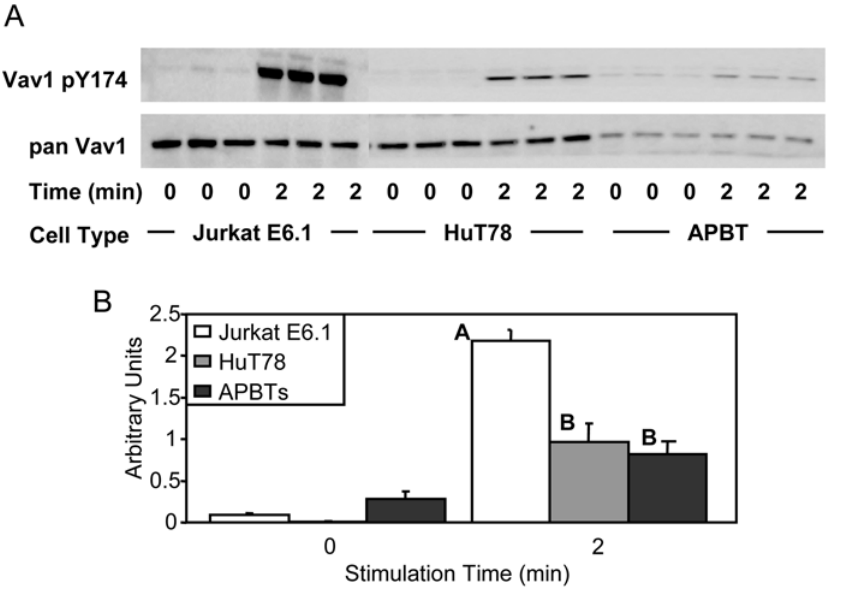
Figure 8. Jurkat E6.1 T cells exhibit hyperphosphorylated of Vav1 Y174 compared to HuT78 T cells and APBTs. (A) Three samples of Jurkat E6.1 T cells, HuT78 T cells, and APBTs were stimulated and the cellular proteins were separated by SDS-PAGE. The site-specific phosphorylation and expression of Vav1 was assessed by immunoblotting using Vav1 pY174 (top) and pan-Vav1 (bottom) antibodies. (B) The immunoblots were analyzed by densitometry and the ratio of the intensity of the phosphospecific Vav1 band to the pan-Vav1 band for each cell line was averaged. Letters represents significant differences of p , 0.005.